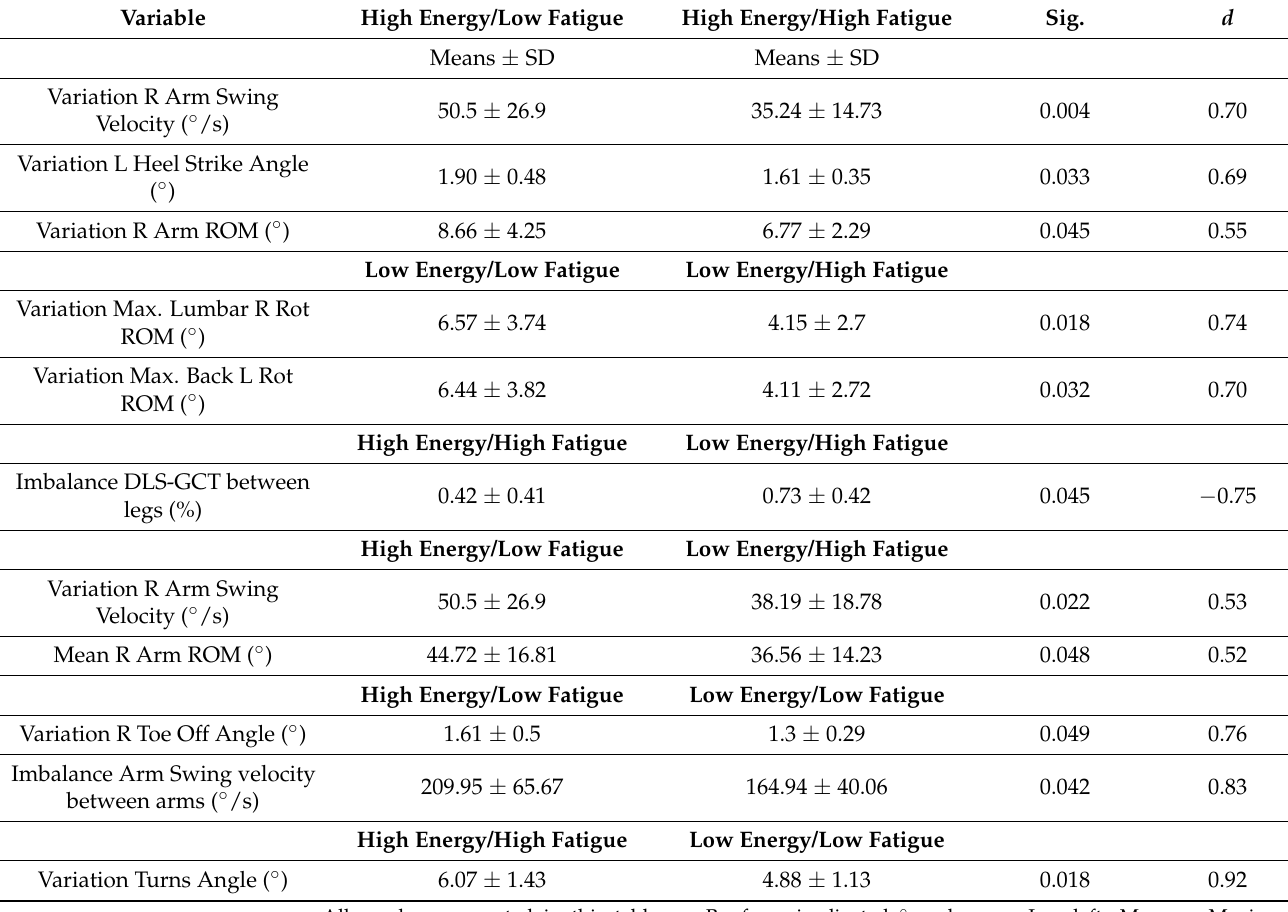
Table 7. Post hoc significant differences between groups for energy and